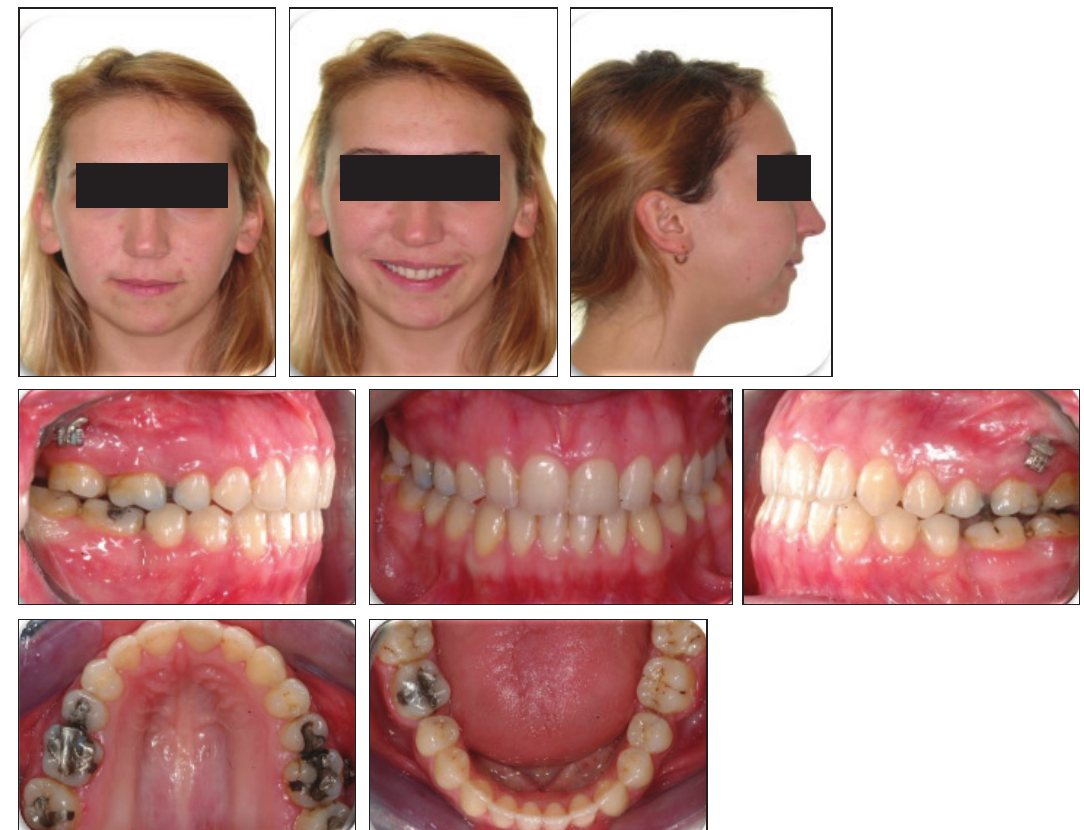
Figure 6. Post-teratment extra- and intra-oral photographs of the